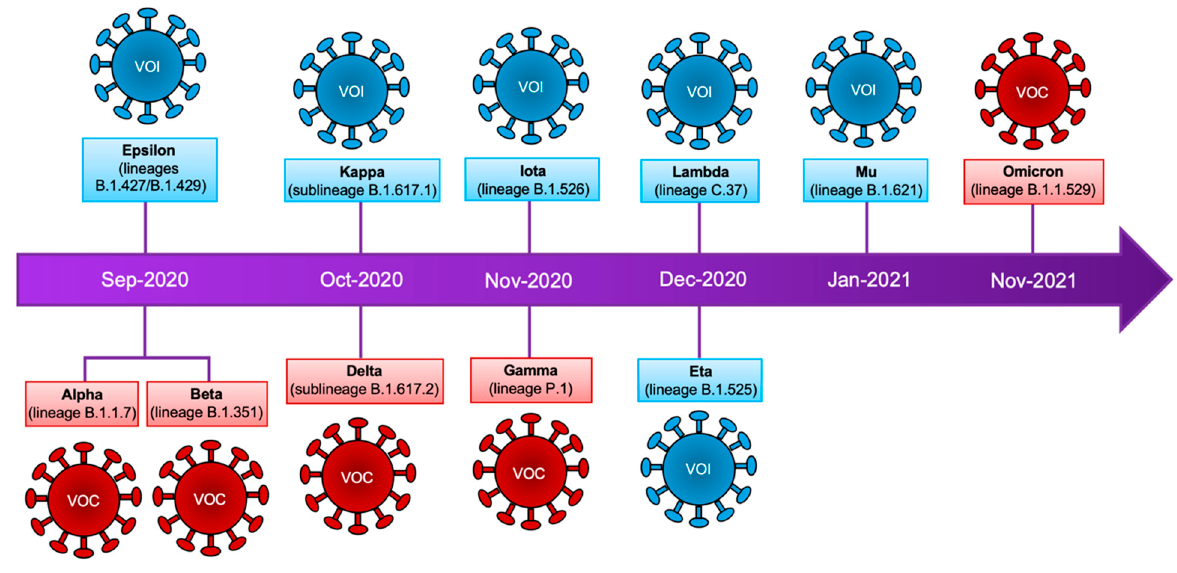
Figure 1. SARS-CoV-2 variants. Timeline that summarizes the emergence of SARS-CoV-2 variants. Classification according to the WHO is shown as well as the lineages of the mutagenic profile. VOC : variants of concern, VOI : variants of interest. Table 2. Variants of SARS-CoV-2.